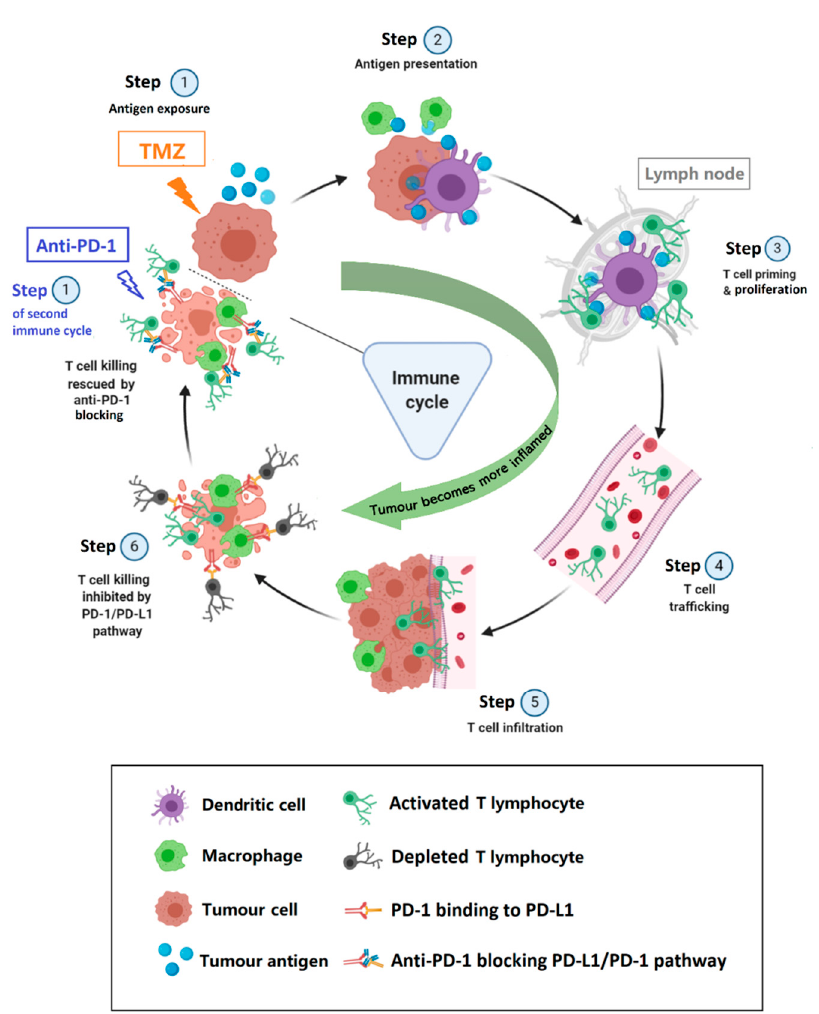
Figure 7. Proposed schema of the cycle for an immune response against a preclinical GL261 GB tumour after two cycles of anti-PD-1/TMZ combined therapy . The cancer-immunity cycle is thought to last around 6 days in the mouse brain and tumour microenvironment: when treated